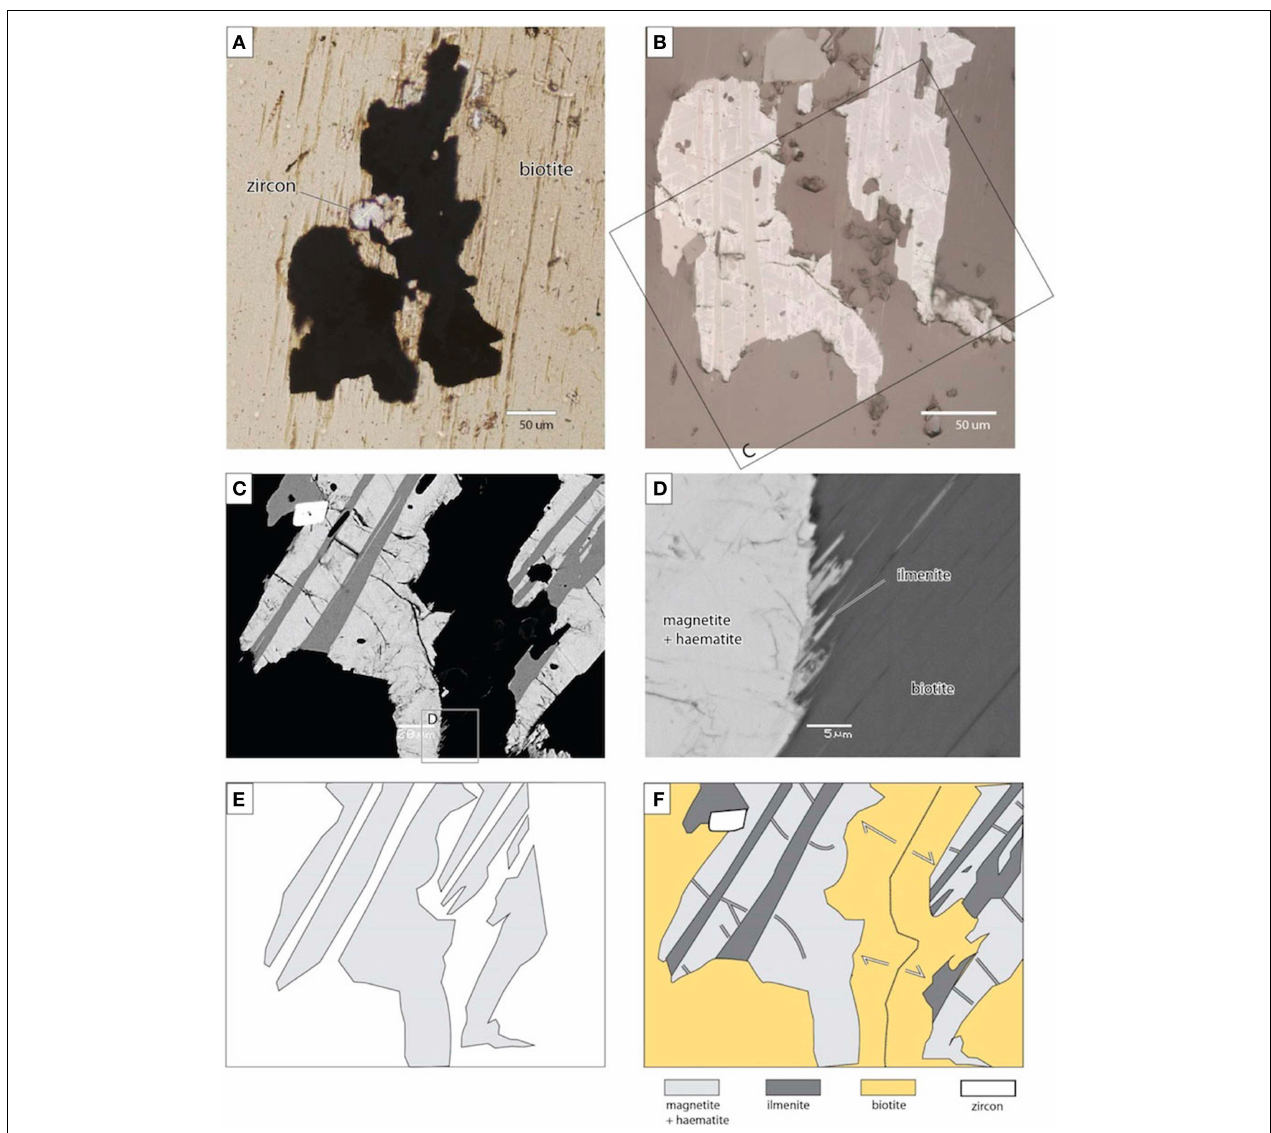
FIGURE 7 | Photomicrographs of magnetite. (A) Photomicrographs of subhedral crystals of magnetite (black minerals) trapped in a poikiloblast crystal of biotite (brown mineral) from the Neoproterozoic terrains of Socotra (Oman). (B) Recognition of treillis-like shaped hematite within the crystal of magnetite under reflected light microscopy. (C) Back-scattered electron imaging on the internal structure of oxide, using a scanning electron microscope (SEM), reveals multiple grains of magnetite-hematite separated by elongated crystals of ilmenite. (D) Oriented needles or patches of ilmenite outline the contact with biotite. (E,F) Interpreted chronology of magmatic events depicted from microscopic and SEM observations: (1) treillis-like shaped hematite developed early along cleavage planes of magnetite, due to magmatic oxy-exsolution processes; (2) magnetite was further fractured and divided into several grains; (3) Cracks were subsequently filled with ilmenite growing in equilibrium with the large magmatic